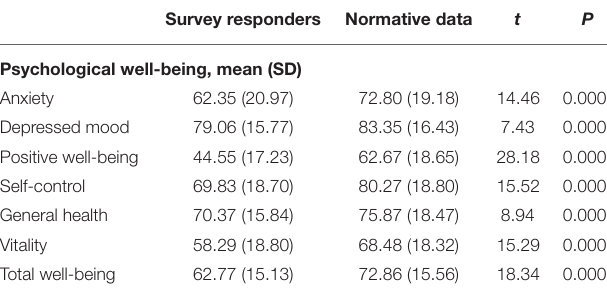
TABLE 5 | Comparisons between responders’ results and normative data on